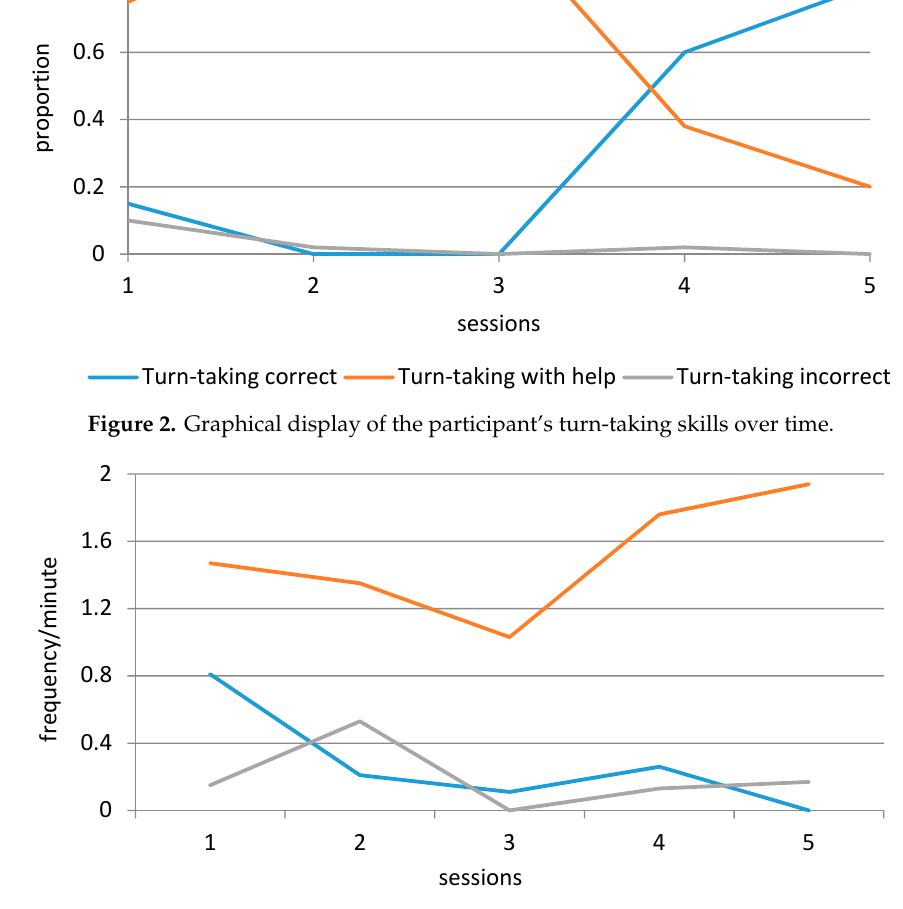
Figure 3. Graphical display of the participant’s separation anxiety and emotions over time.